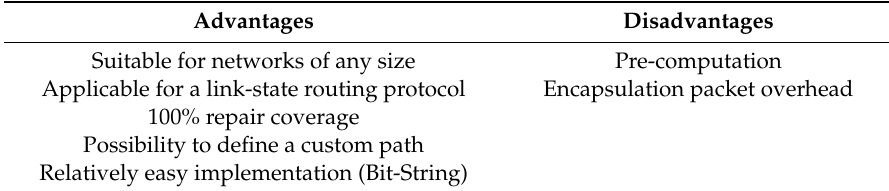
Table 7. Properties of the B-REP algorithm.